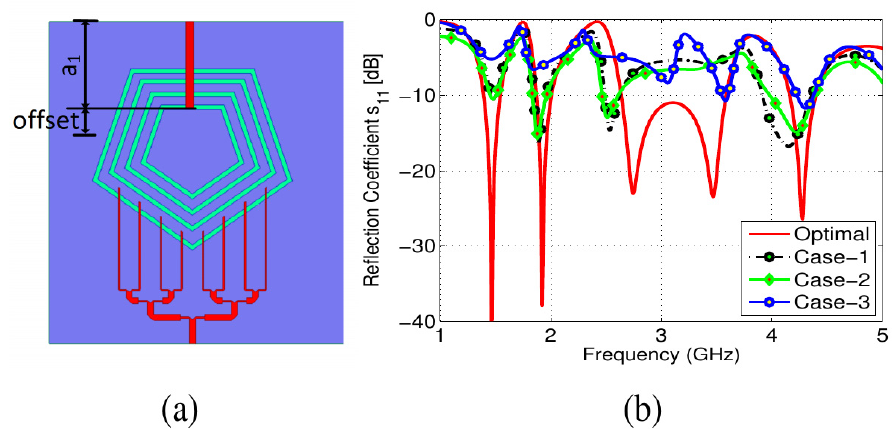
6 of 19 Figure 3. Steps in the design process: ( a ) S 11 with one slot, ( b ) S 11 with two slots, ( c ) S 11 with four slots, ( d ) S 11 with an inner pentagonal plate slot. A 50 Ω microstrip line was used to feed the pentagonal slot-line structure. The stand- ard microstrip line equation was used to calculate the feed line width. Each pentagonal slot resonated at its fundamental and higher order modes. The four concentric slots were